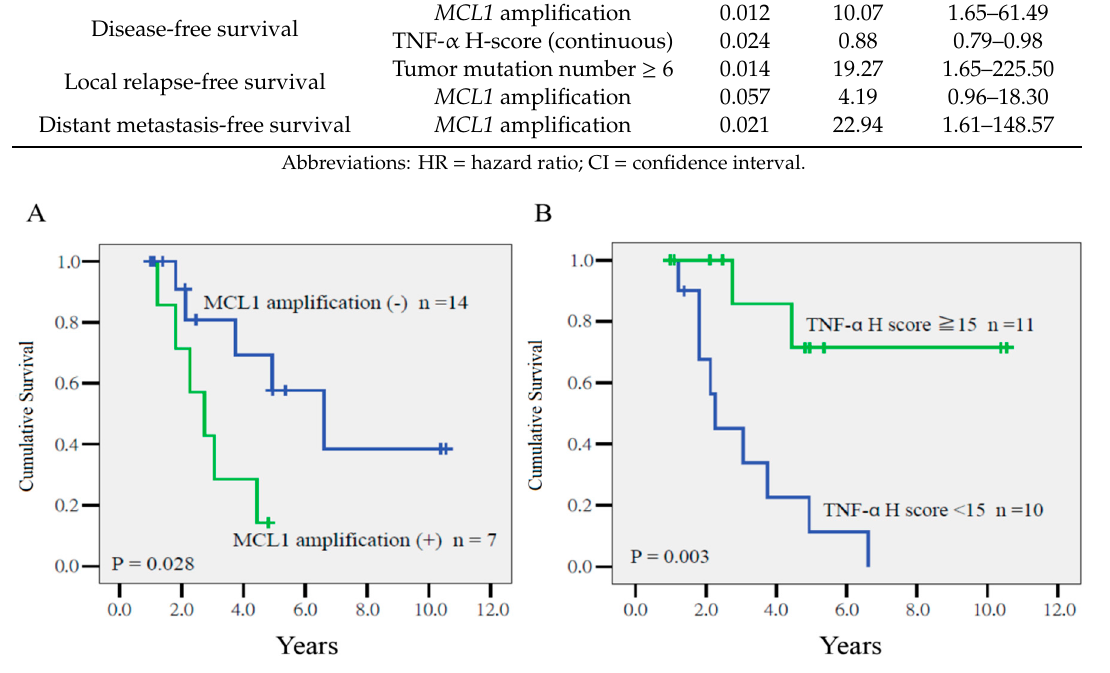
Figure 1. Disease-free survival in patients who had tumors with or without myeloid cell leukemia-1 ( MCL1 ) amplification ( A ), and a high ( ≥ 15) or low TNF- α H-score (<15) ( B ) ( p = 0.028 and p = 0.03, respectively).